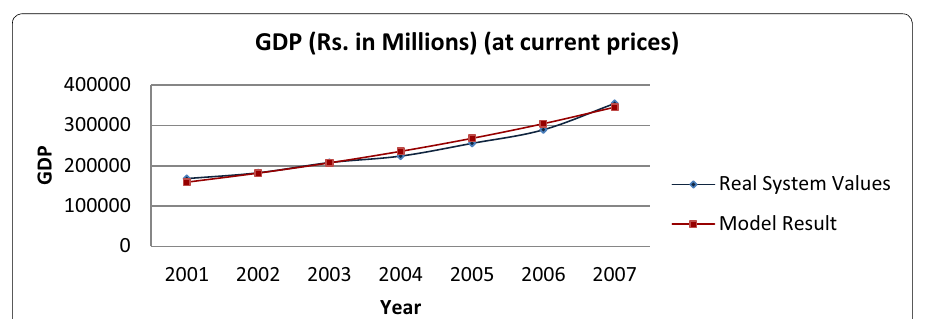
Fig. 10 GDP (Rs. in millions) (at current prices). The graph showing the comparison between real system values and the model generated values from the year 2001 to 2009. The line in blue colour represents the real system values, and the line in red colour shows the model values of Gross Domestic